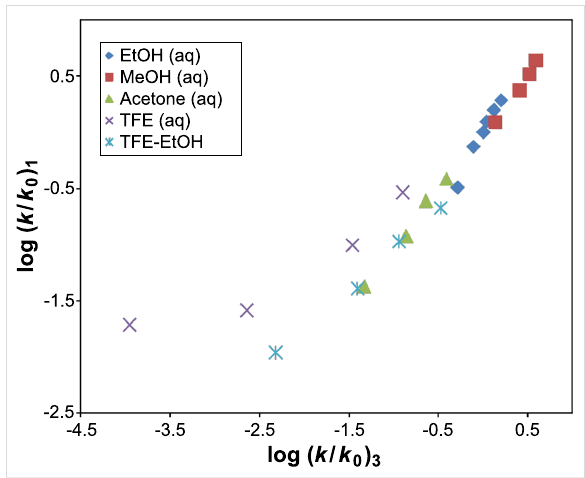
Figure 2: The plot of log ( k / k 0 ) for iBuOCOCl ( 1 ) against log ( k / k 0 ) for PhOCOCl ( 3 ).